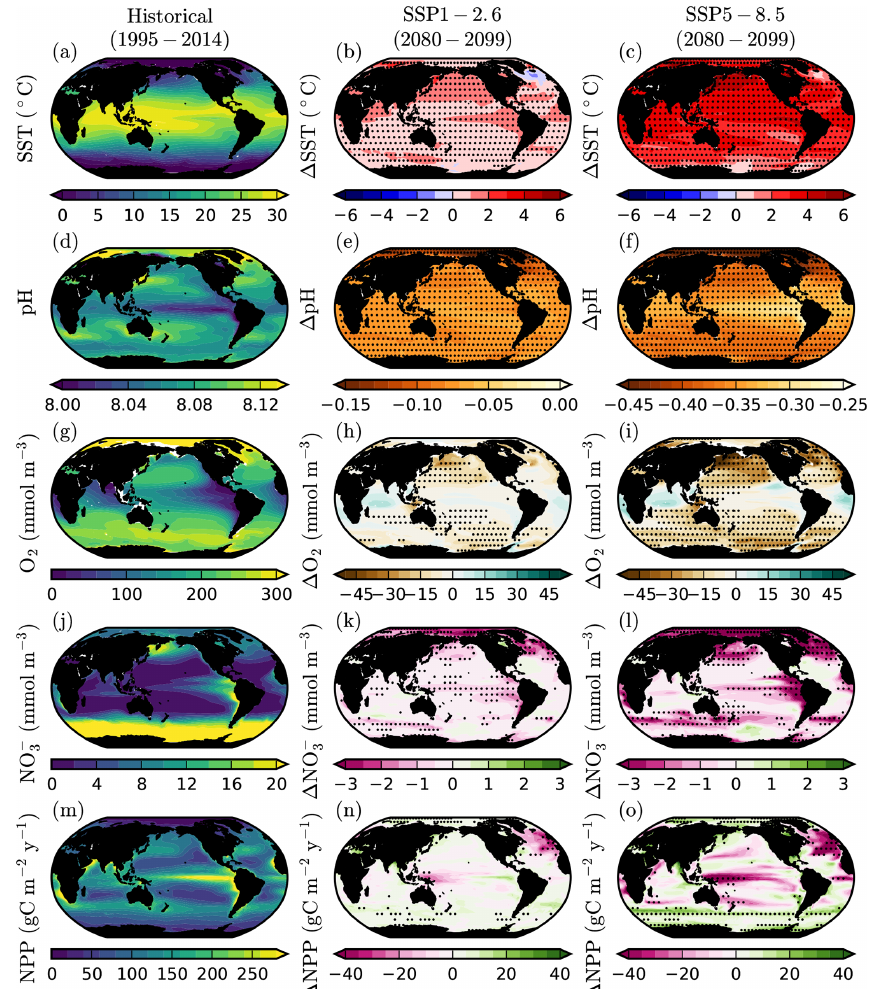
Figure 2. Projections of multiple upper-ocean impact drivers under SSP1-2.6 and SSP5-8.5. CMIP6 mean historical climatologies and twenty-first century anomalies in (a–c) sea surface temperature ( ◦ C), (d–f) surface ocean pH, (g–i) subsurface dissolved O 2 concentration (averaged between 100 and 600m ; mmolm − 3 ), (j–l) euphotic-zone NO − (averaged between 0 and 100m ; mmolm − 3 ), and (m–o) depth- 3 integrated net primary production (gCm − 2 y − 1 ). Anomalies are 2080–2099 mean values relative to the 1995–2014 baseline period. Stippling designates areas of projection robustness. For temperature and pH this is defined as the magnitude of the mean anomaly exceeding the inter- model SD. For O 2 , NO 3 , and NPP this is defined as at least 80% model sign agreement.